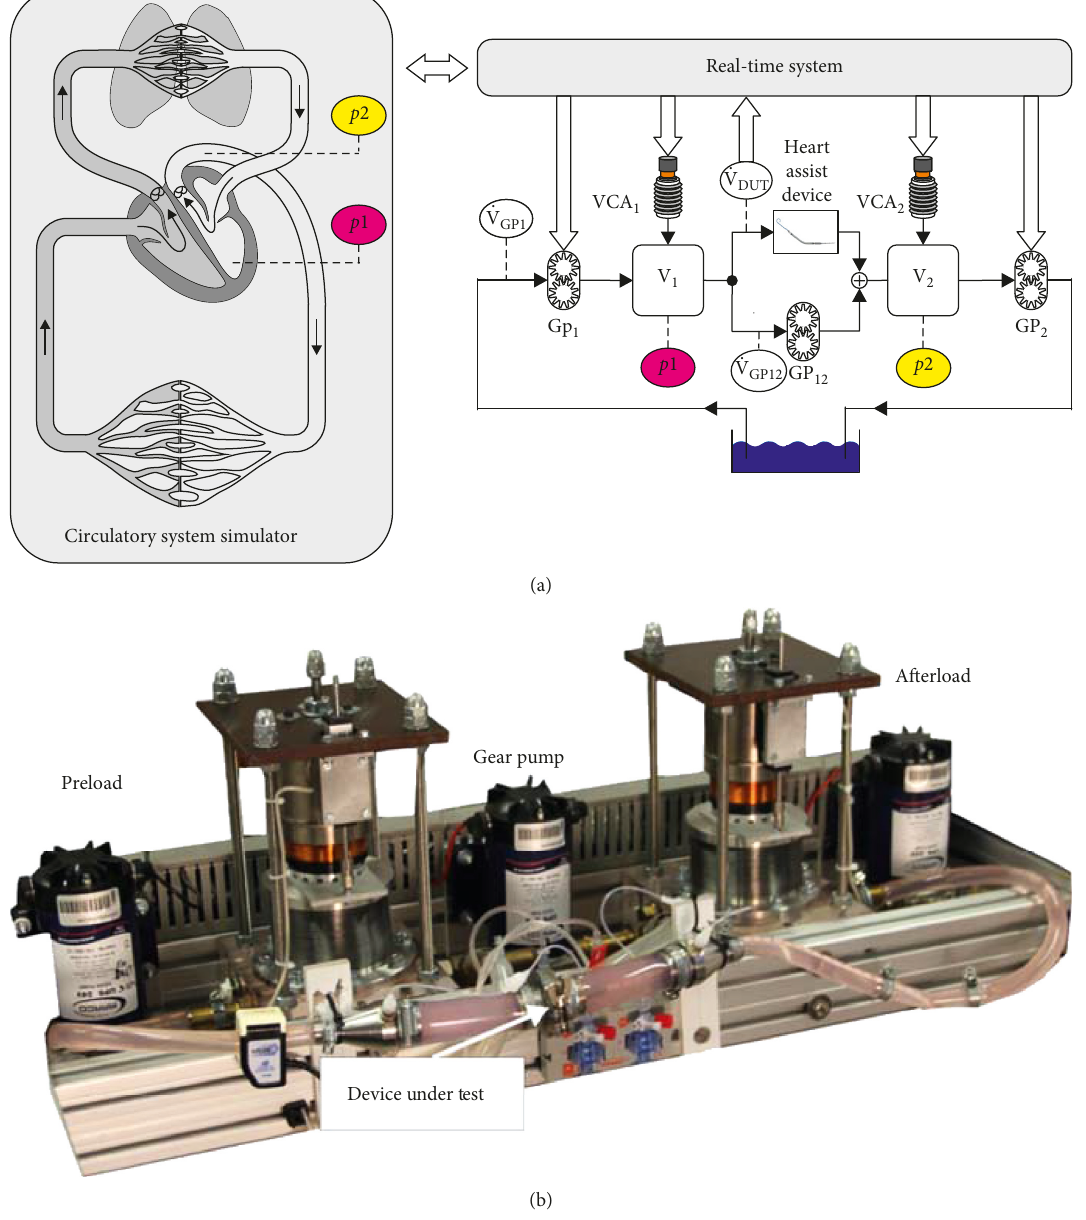
Figure 3: (a) Hydrodynamic system simulator (right) coupled to the circulatory system simulation (left). The left ventricular pressure p1 (preload) and the aortic arch pressure p2 (afterload) are calculated via the simulation and used as reference values for the hybrid adult mock circulation. Measured values in the experimental setup are indicated by ellipsoids, modified from the literature values. (b) Photo of the hybrid adult mock circulation (HAMC). The preload and afterload pressure compartments with the attached voice coil actuators can be seen as well as the three gear pumps providing the flow balance in the system. The device under test is mounted in the fixation in front. A detailed description of the system can be found in